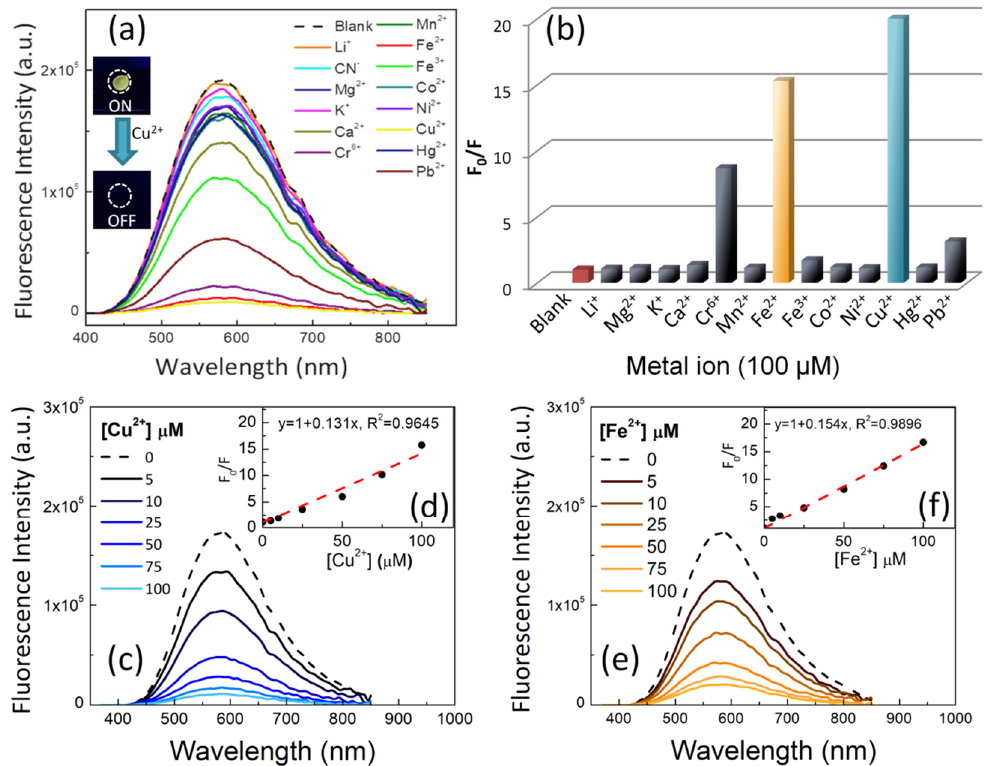
Figure 6. ( a ) Selectivity of ZnO@HP 6k towards different metal ions ([Metal ion] = 100 μ M); ( b ) ratio between initial integrated emission and integrated emission (F 0 /F) of ZnO@HP 6k in the presence of 100 μ M of the indicated metals; ( c ) decrease in fluorescence emission of ZnO@HP 6k as a function of Cu 2+ concentration (5–100 μ M); ( d ) Stern–Volmer plot corresponding to ZnO@HP 6k quenched by Cu 2+ ; ( e ) decrease in fluorescence emission of ZnO@HP 6k as a function of Fe 2+ concentration (5–100 μ M); ( f ) Stern–Volmer plot corresponding to ZnO@HP 6k quenched by Fe 2+ .